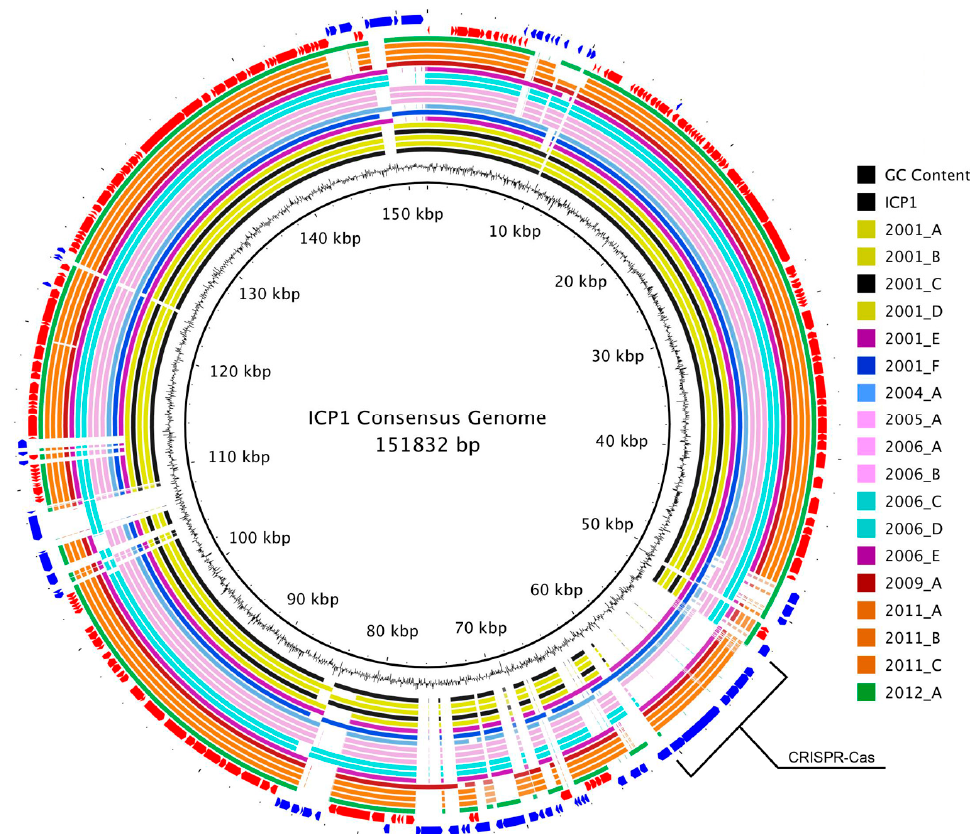
Figure 2. ICP1 pan-genome consensus alignment. A BLASTn-based whole genome alignment of all 19 ICP1 phage genomes using the MAUVE alignment consensus sequence as a reference. The innermost ring is the consensus sequence. The next ring represents the GC content for that region. The following 19 rings display the alignment for each genome and are colored by phylogenetic similarity as determined by the analysis of whole genomes (Figure 1, left). The second to last ring (red) represents the core-genomic ORFs, while the outermost ring (blue) is the accessory-genome ORFs. The CRISPR-Cas insertion region is